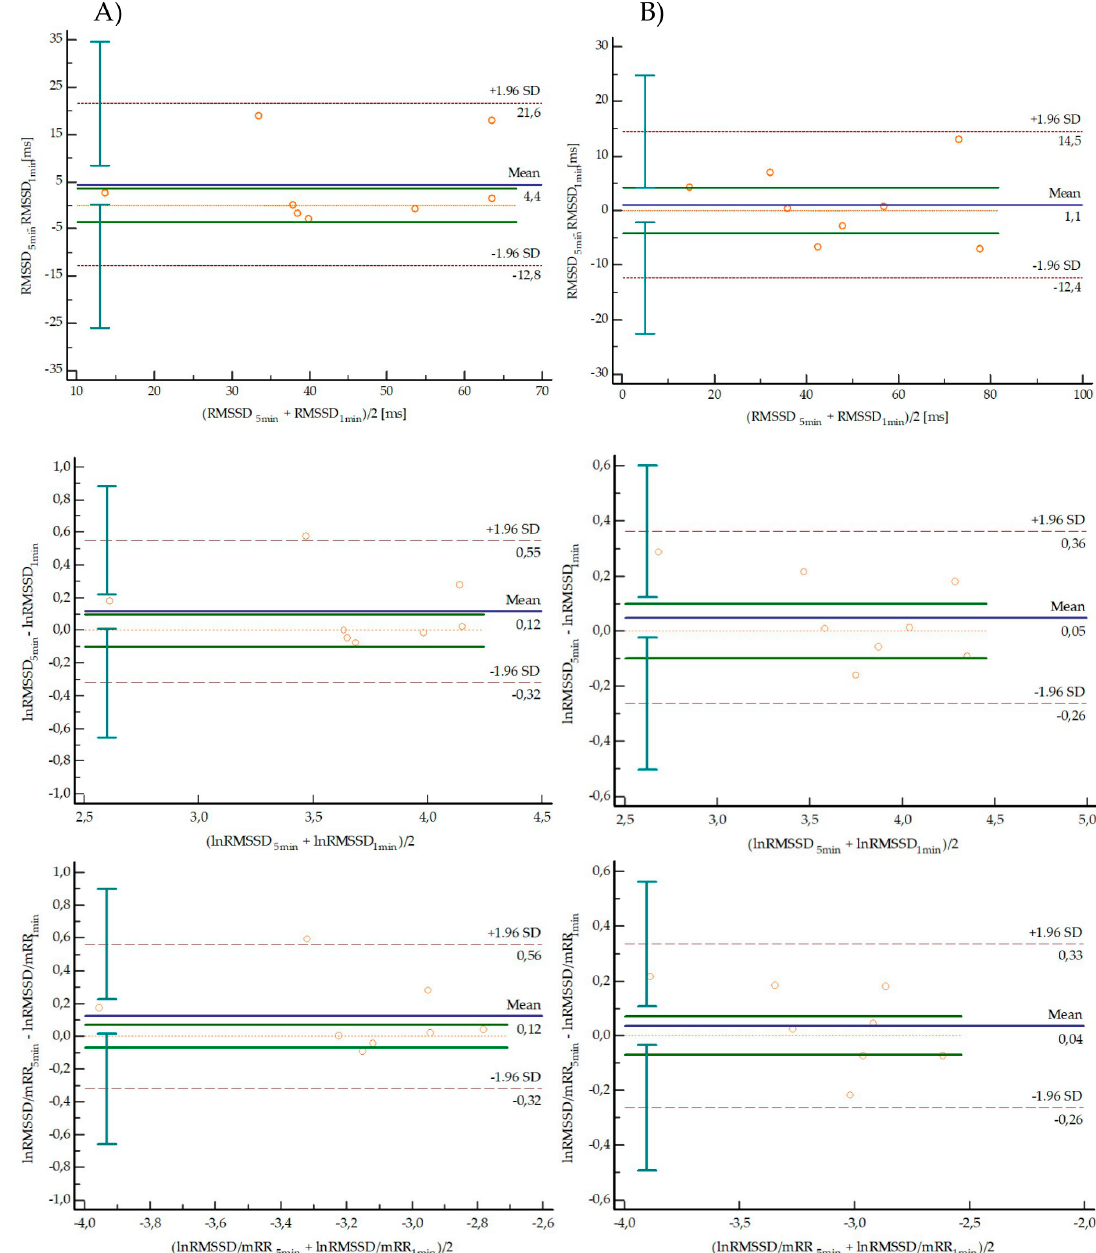
Figure 3. Bland–Altman plots representing the agreement between the 1 min and 5 min in selected HRV parameters in both Test (column A ) and Retest (column B ) periods. The solid blue line indicates the bias, dotted red lines are the 95% LoA ( ± 1.96 SD), vertical lines are confidence interval LoA limits, solid green lines are a priori defined maximum allowed difference.